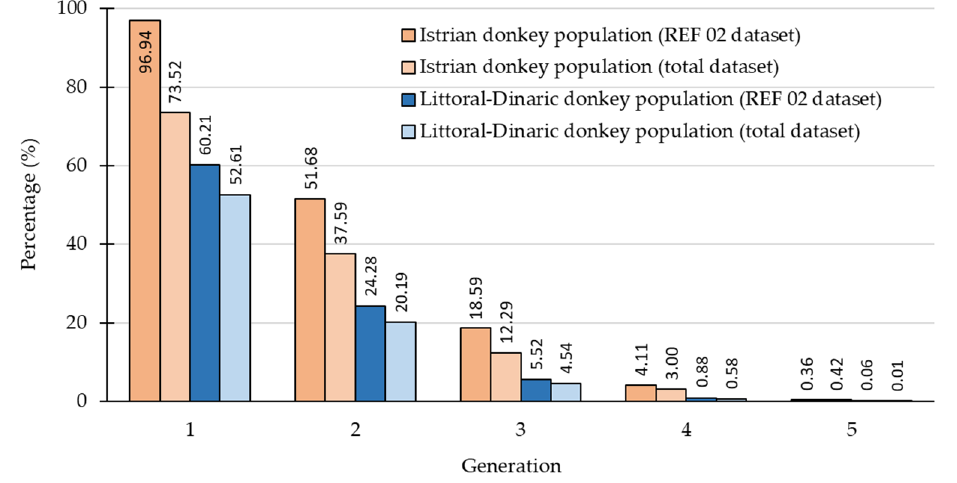
Figure 4. Average percentage of total pedigree completeness and REF 02 reference populations of the Littoral-Dinaric donkey and Istrian donkey.